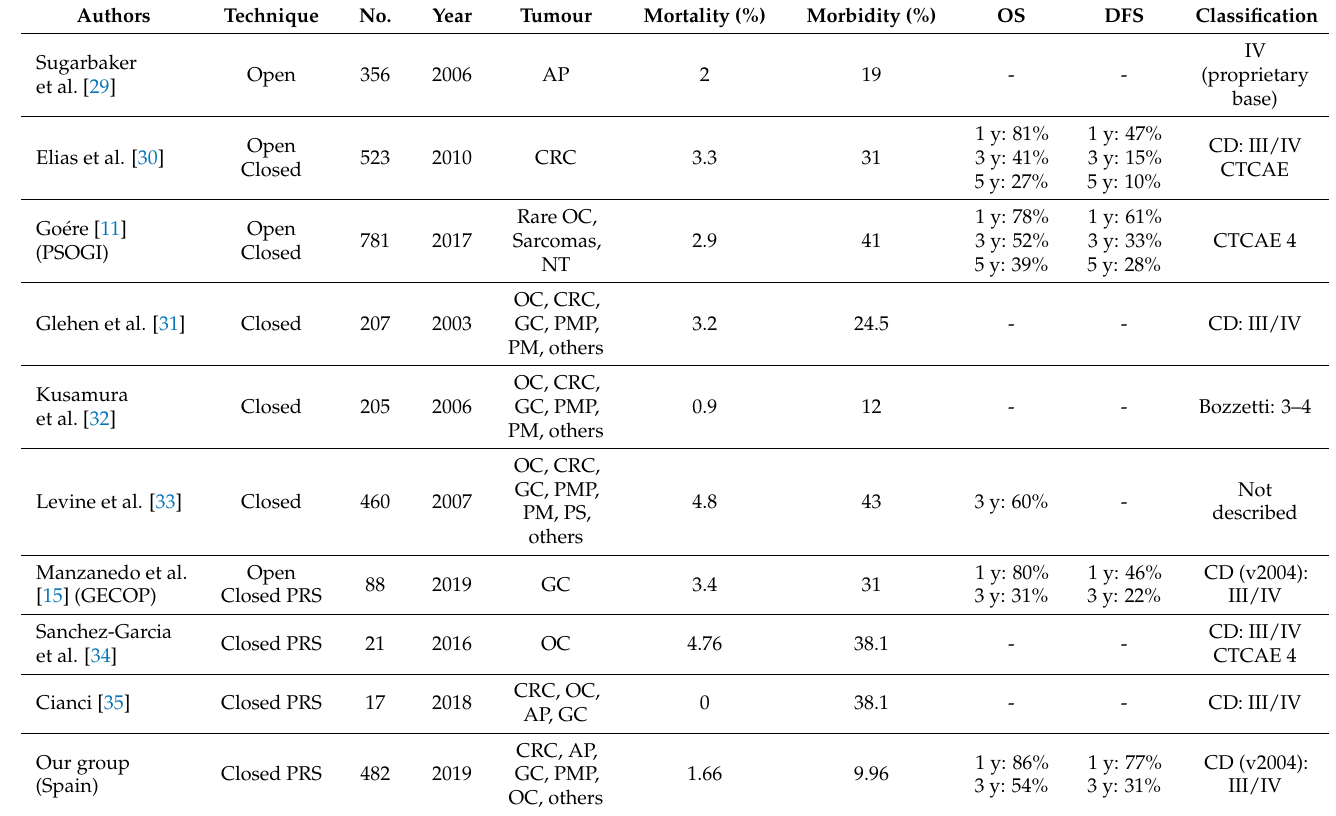
Table 4. Comparison of morbidity/mortality and survival among various series related to the HIPEC technique